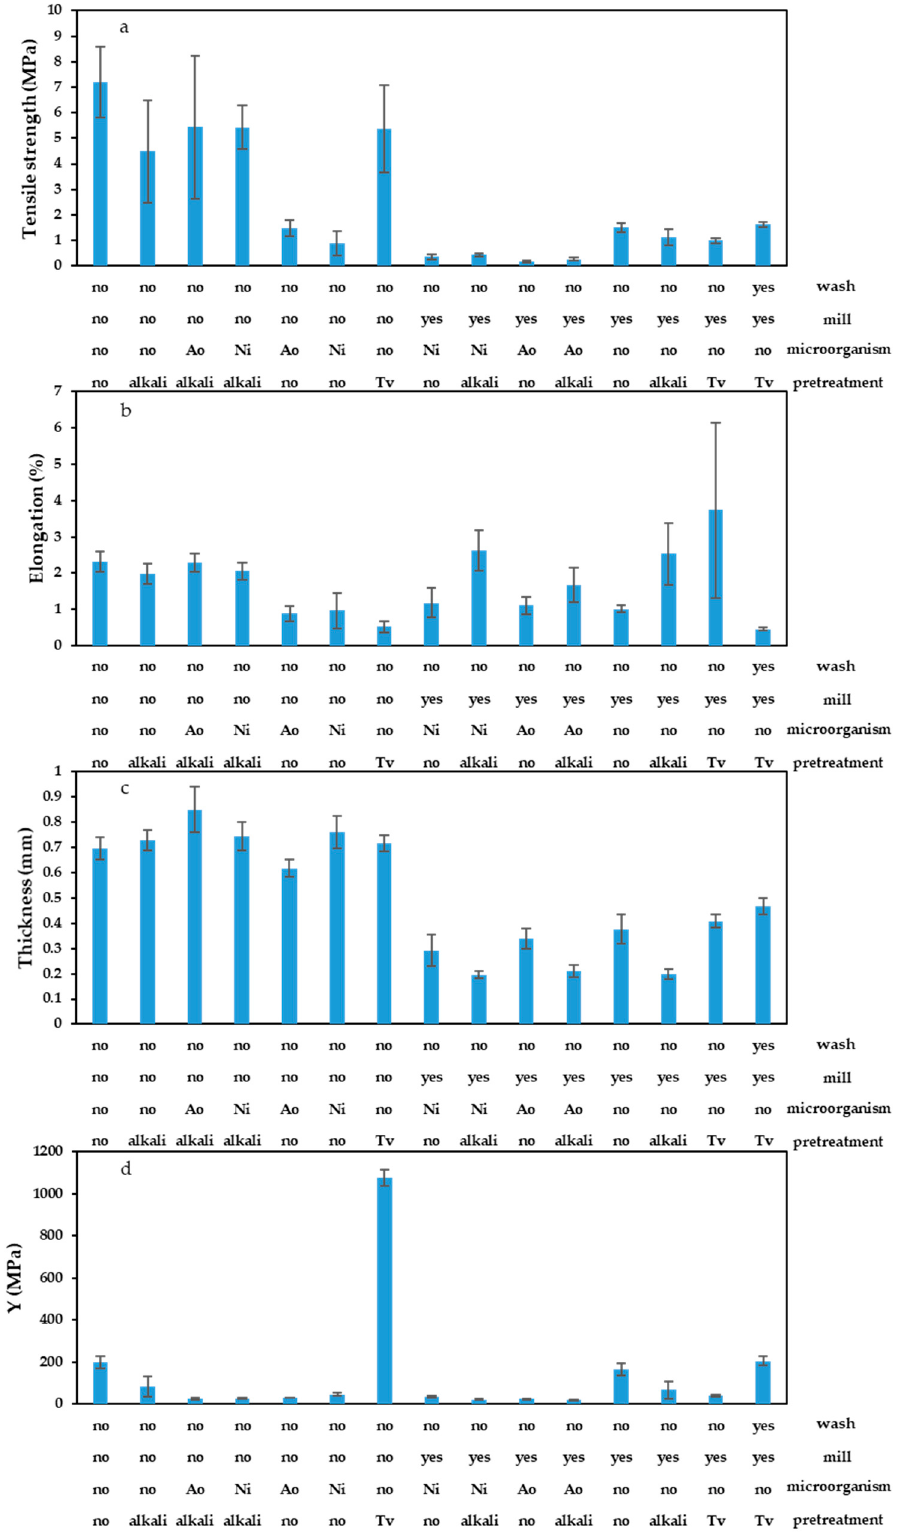
Figure 2. ( a ) Tensile strength (MPa), ( b ) elongation at break (%), ( c ) thickness (mm), and ( d ) Young’s modulus (MPa) of the films made with wheat bran. Individual standard deviations were used to calculate the intervals. Number of replicates = 5; confidence interval for the means of 95%. Ni, Ao, and Tv stands for N. intermedia , A. oryzae, and T. versicolor , respectively.